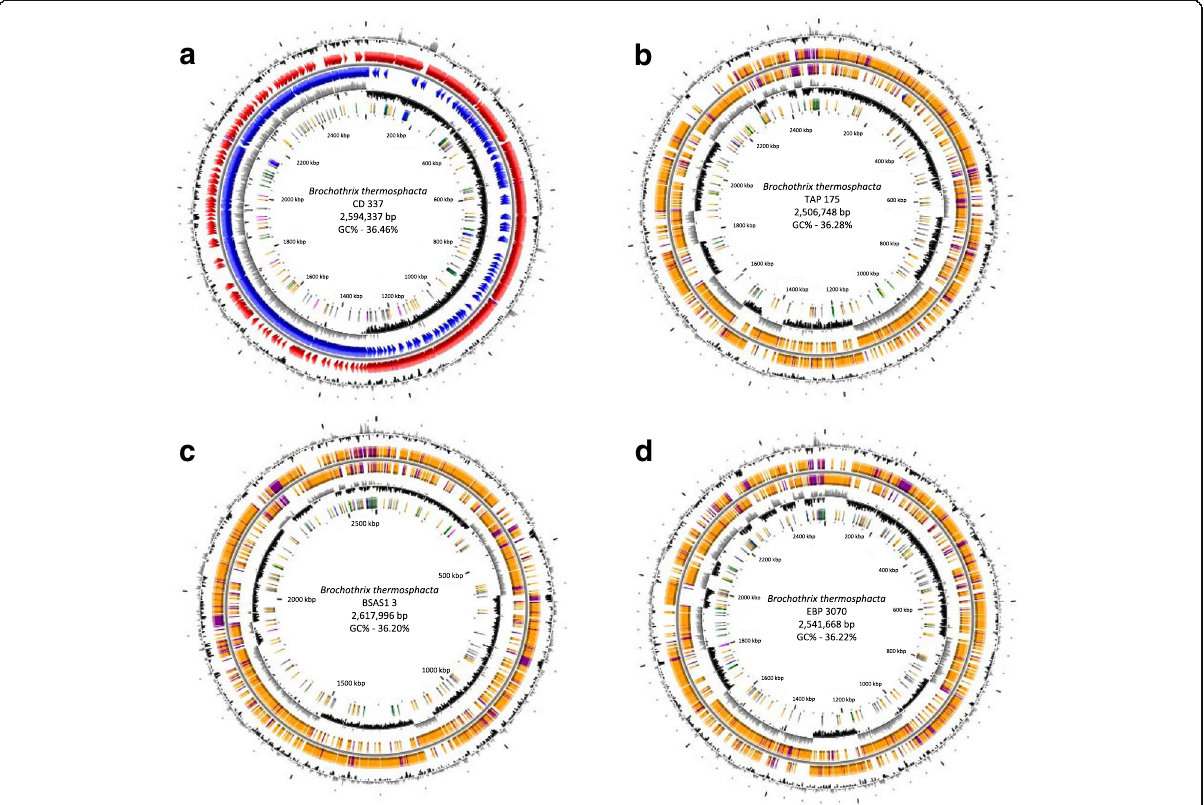
Fig. 3 Circular views of genome sequences of Brochothrix thermosphacta CD 337 ( a ), B. thermosphacta TAP 175 ( b ), B. thermosphacta BSAS1 3 ( c ), and B. thermosphacta EBP 3070 ( d ). The circular display shows, from outside to inside: (i) GC percentage; (ii) Predicted CDSs transcribed in the clockwise direction; (iii) Predicted CDSs transcribed in the counterclockwise direction. In (ii) and (iii), red and blue colors represent MaGe validated annotations, orange color represents the MicroScope automatic annotation with a reference genome, and the purple color represents Primary/ Automatic annotations; (iv) GC skew (G + C/G-C) and (v) color-code representing rRNA (blue), tRNA (green), miscellaneous RNA (orange), Transposable elements (pink) and pseudogenes